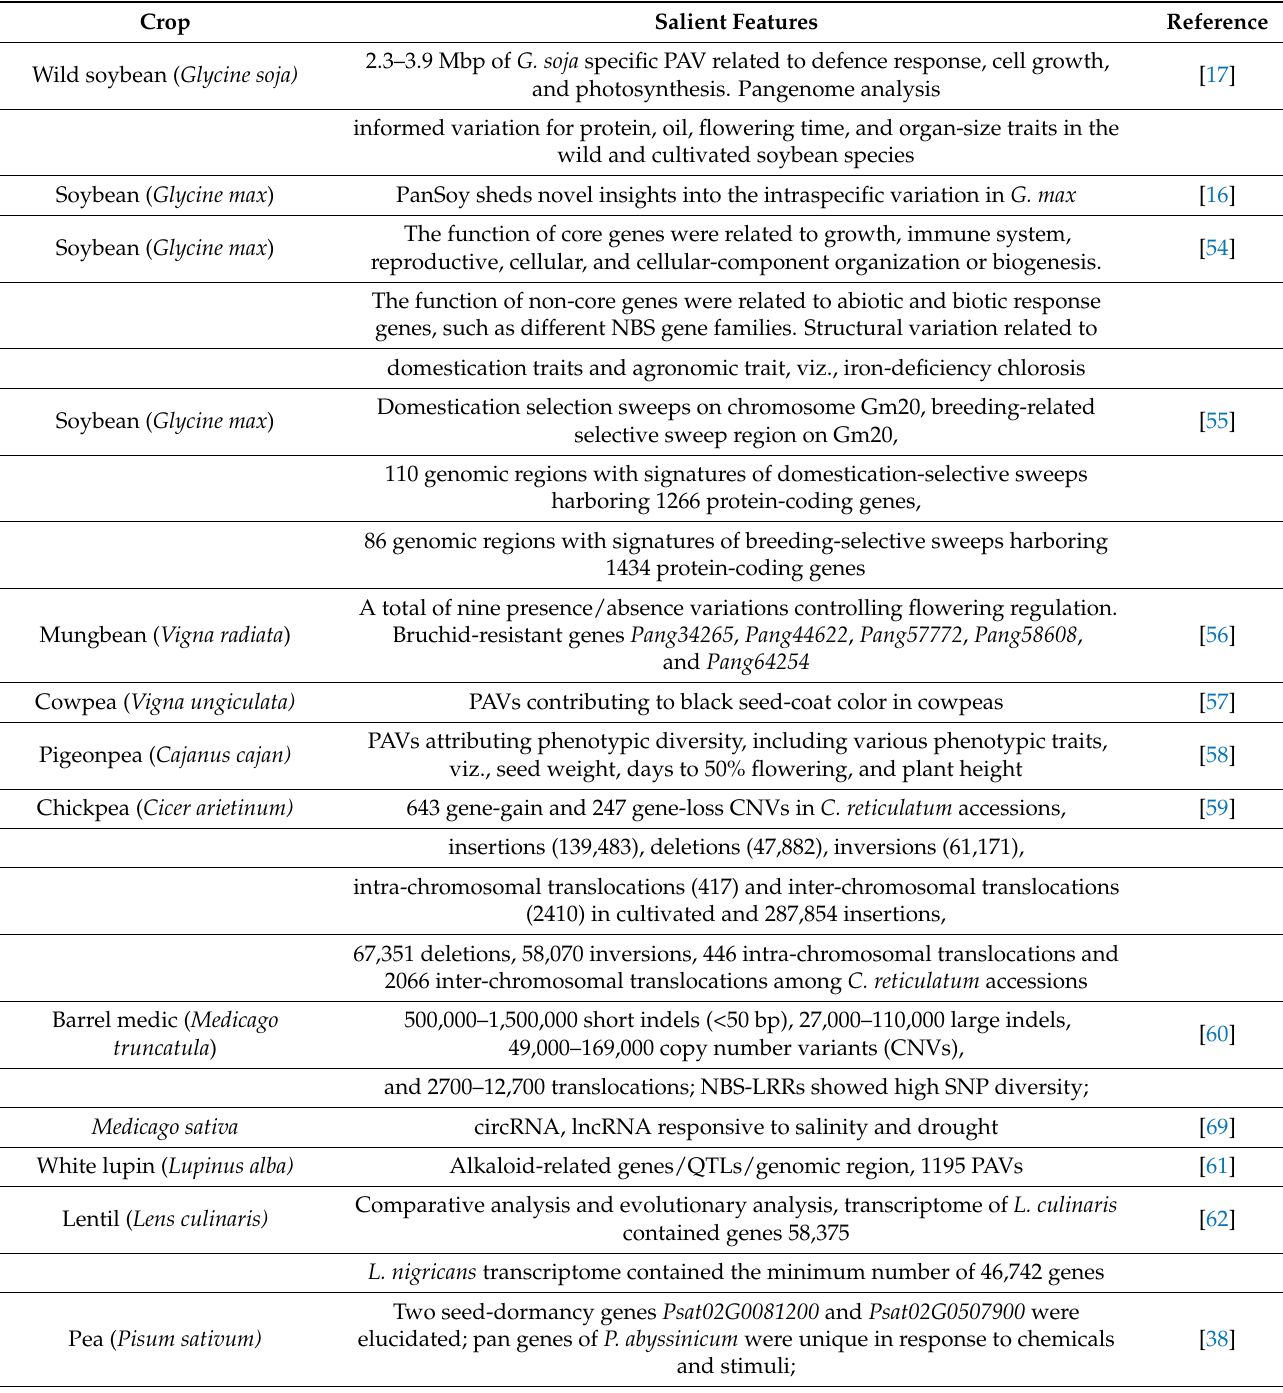
Table 2. Applications of pangenome in various legume